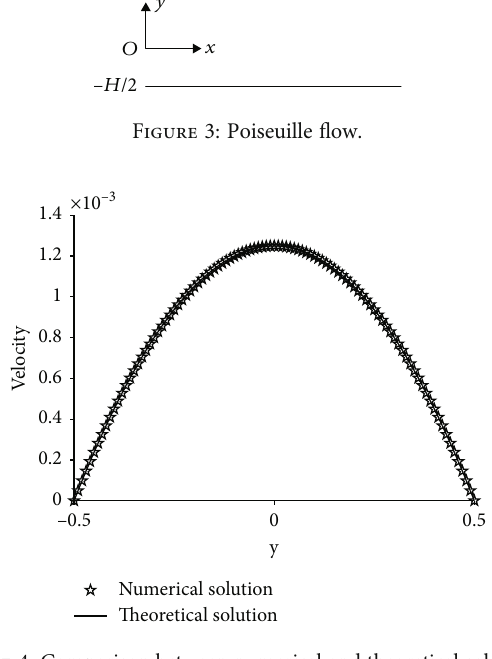
Figure 4: Comparison between numerical and theoretical solutions.